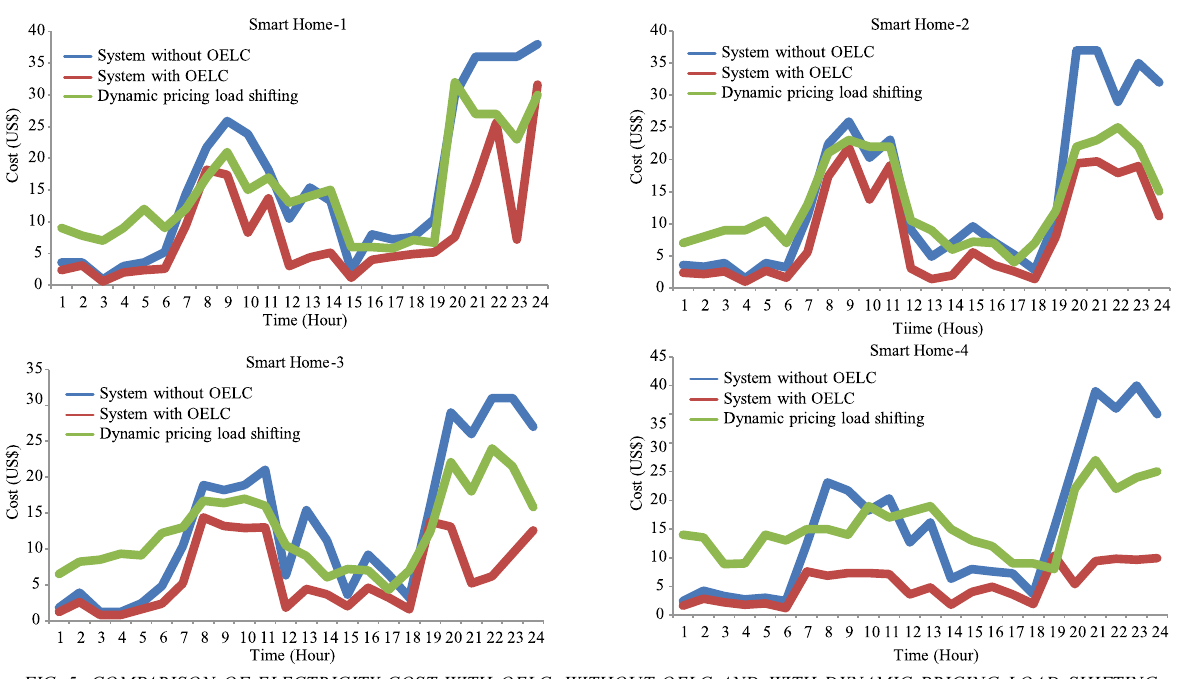
FIG. 5. COMPARISON OF ELECTRICITY COST WITH OELC, WITHOUT OELC AND WITH DYNAMIC PRICING LOAD SHIFTING SYSTEM FOR 4 SAMPLE SMART HOMES USED DURING